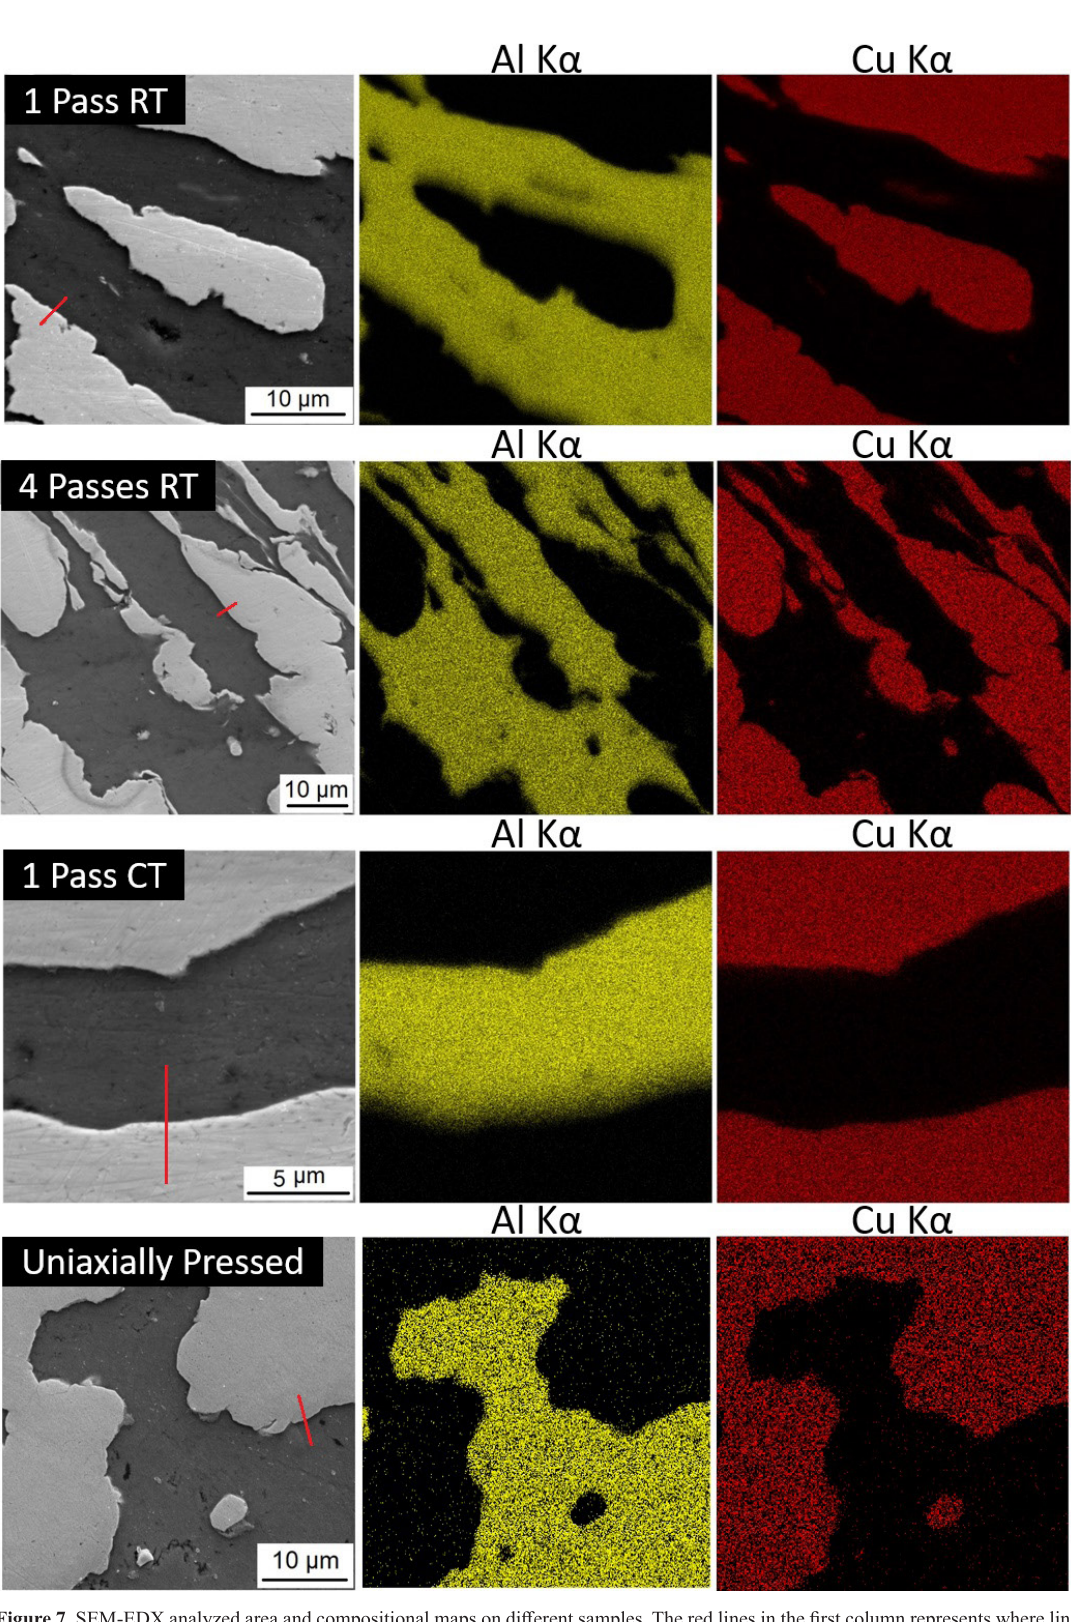
Figure 7. SEM-EDX analyzed area and compositional maps on different samples. The red lines in the first column represents where line scans were